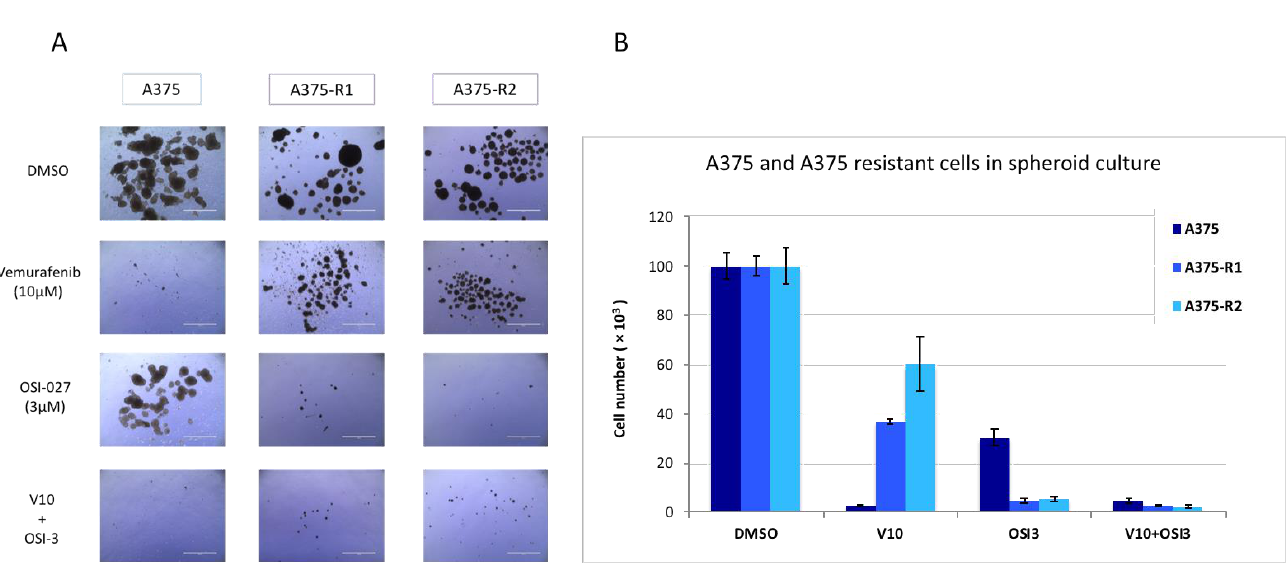
Figure 5. The implication of mTORC2/RICTOR in the resistance of melanoma to targeted therapies in cells grown as spheroids. ( A , B ) A375 parental and resistant cell lines were grown as spheroids and treated with DMSO, Vemurafenib (10 μM), OSI-027 (3 μM) , or the combination of both for 10 days and counted. Pictures were taken after 10 days of treatment; scale bar represents 1000 μm. Graphs represent the mean ± s.d. of an experiment in triplicate (similar results were obtained in three independent experiments).